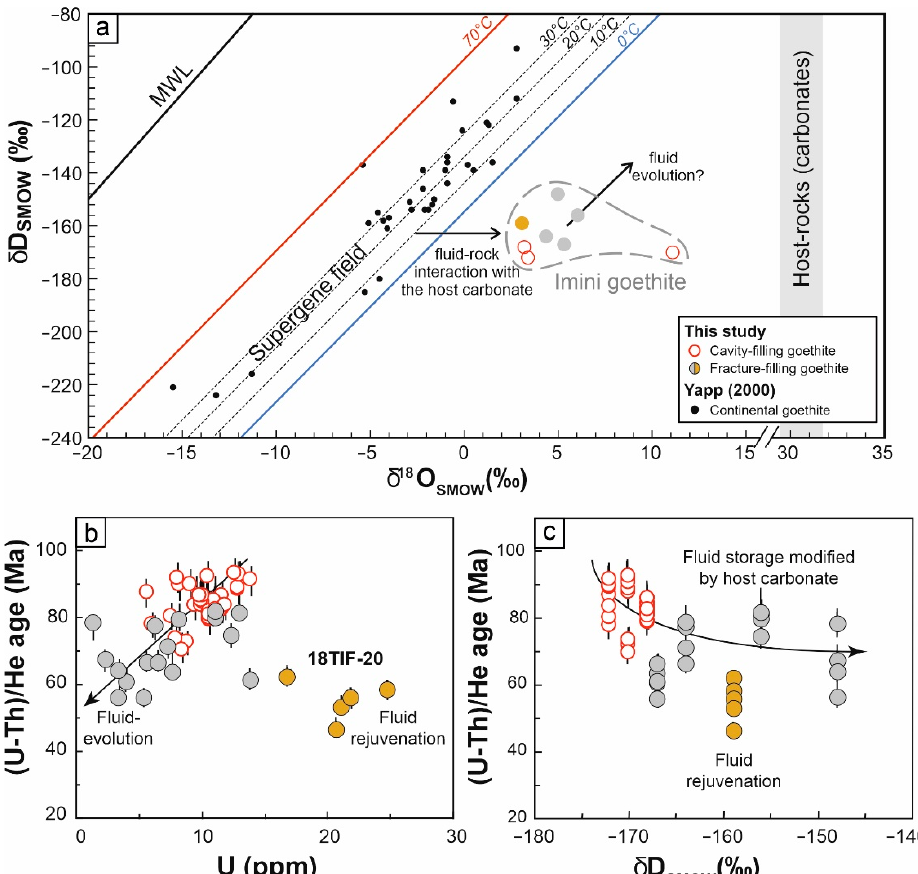
Figure 7. δ D, δ 18 O and (U-Th)/He data of Imini goethite. ( a ) Evolution of the δ D and δ 18 O values of the studied goethite. Continental goethite from [31] is reported for comparison as part of the supergene field. Temperature lines are calculated from [32]. The meteoric water line (MWL) of [33] is given for reference. Carbonate ranges of values of Cenomanian-Turonian dolostones are given by the gray shade [34]. ( b , c ) Imini goethite GHe age variation as a function of the effective uranium U content and the δ D values, respectively. Cavity- and fracture-filling goethite (open red circle and orange circle, respectively) is reported. Sample 18TIF-20 fracture-filling goethite is distinguished from the other samples with a star filling the orange circle.